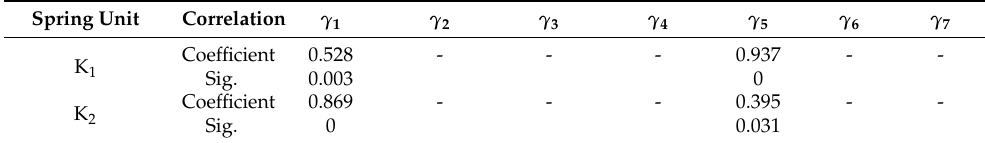
Table 4. Correlation between spring stiffness and frequency correlation